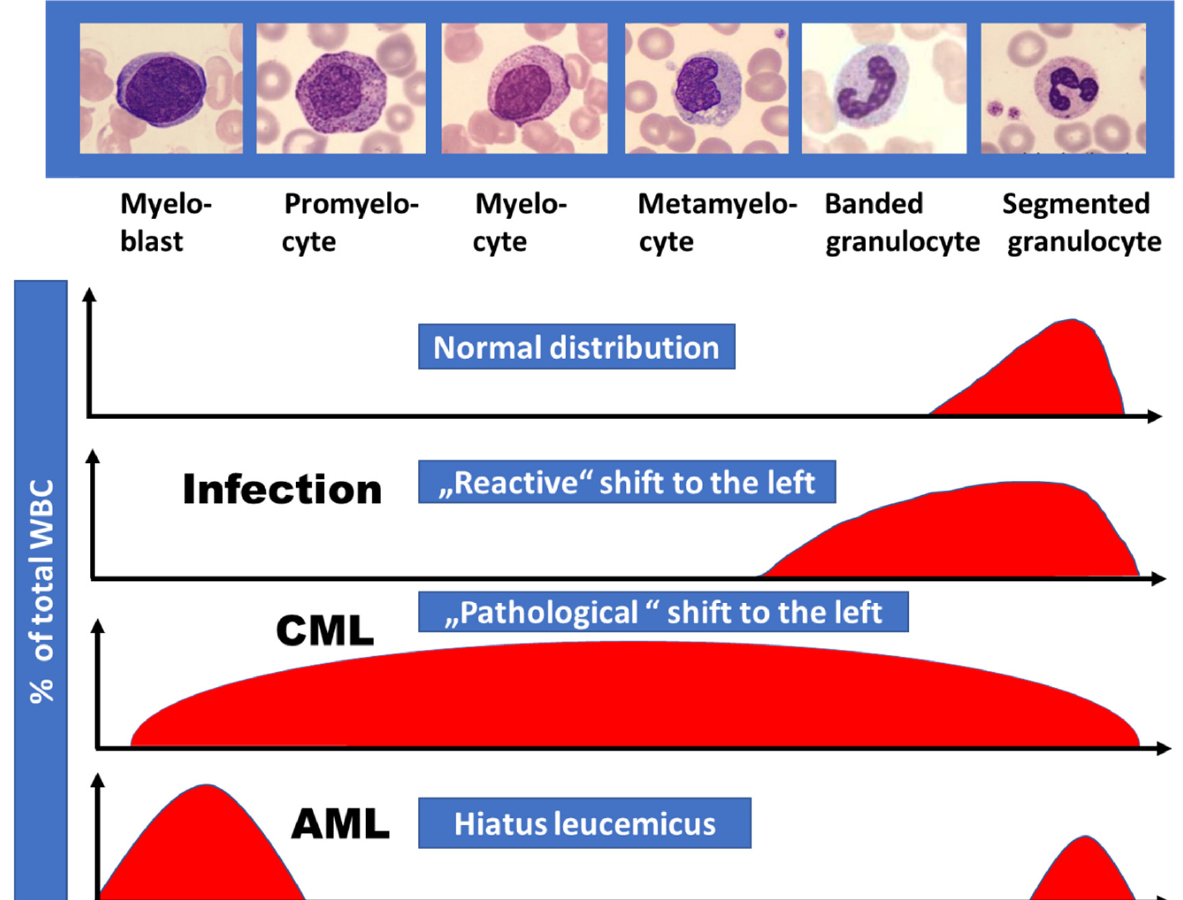
Figure 3. Proportion of immature granulopoietic cells (“shift to the left”) as observed in the differential white cell count in different diseases. Compared to the reactive shift to the left in bacterial infectious diseases, CML is characterized by the presence of more immature granulopoietic cells in addition including myeloblasts. In AML “hiatus leucemicus” (Latin, meaning “leukemic gap”) usually is observed exhibiting myeloblasts and mature granulocytes only.